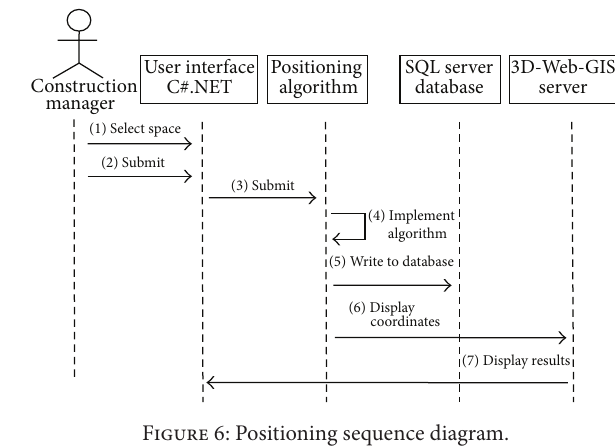
Figure 6: Positioning sequence diagram.